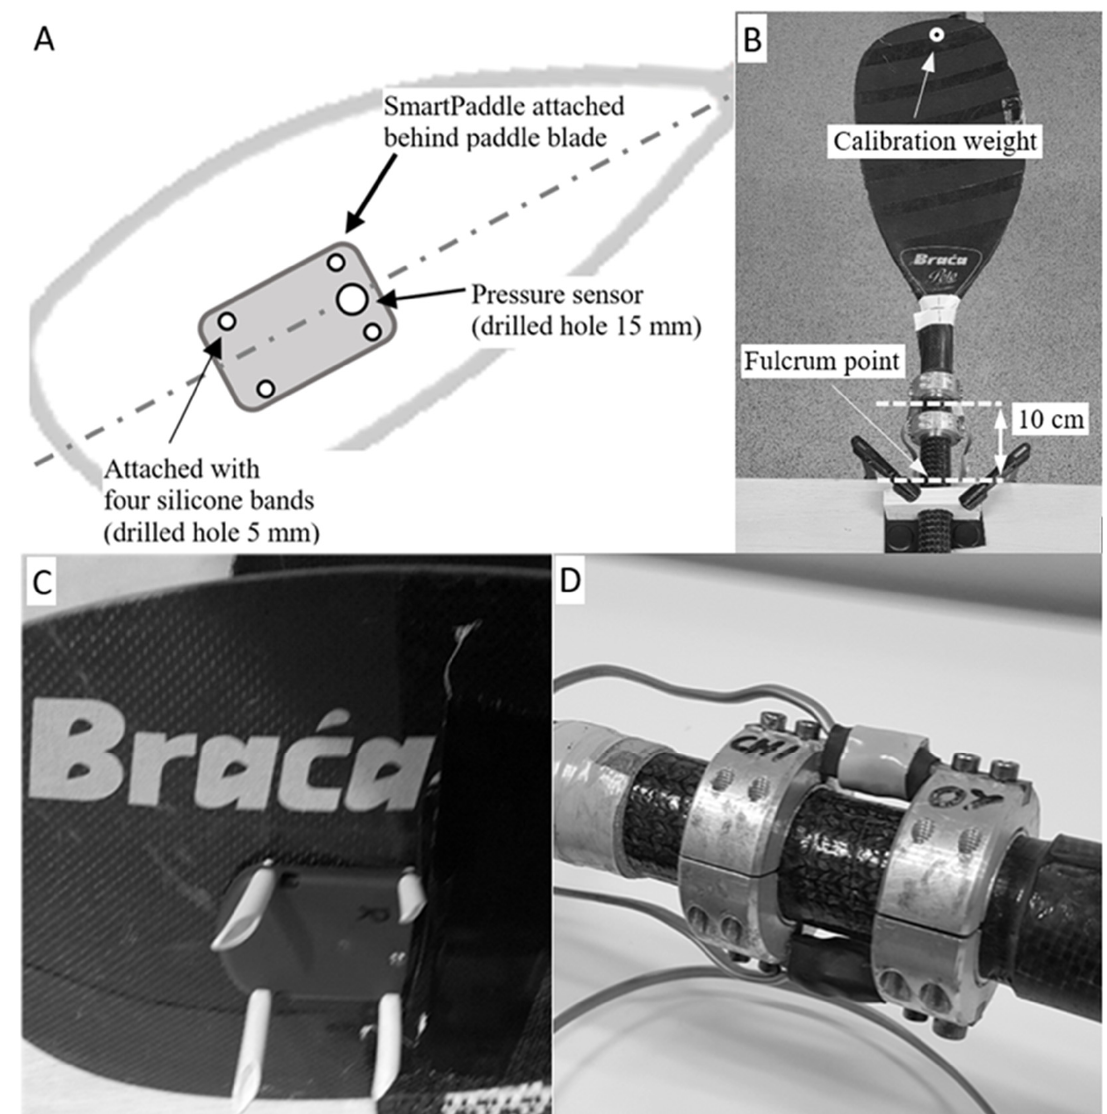
Figure 1. ( A ) SmartPaddle place on the blade, ( B ) Strain-gauge shaft in calibration board (without IMU attached), ( C ) SmartPaddle attached to the blade, ( D ) structure of the strain-gauge